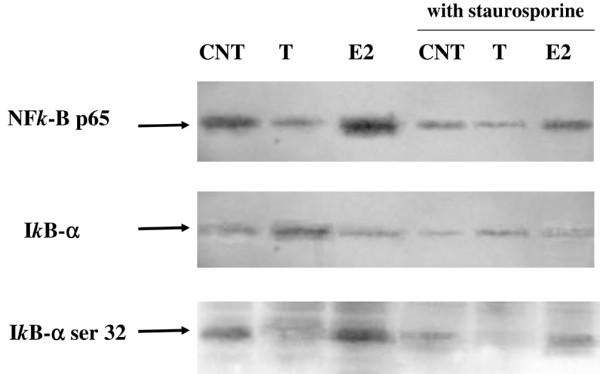
NF-κB p65, IκB-α and phosphorylated IκB-α (ser 32) protein expression in the cultured human THP-1 cell line after 168 hours of hormonal treatment without or with staurosporine. The results are representative of four separate experiments. CNT, control; T, testosterone; E2, 17β-oestradiol.